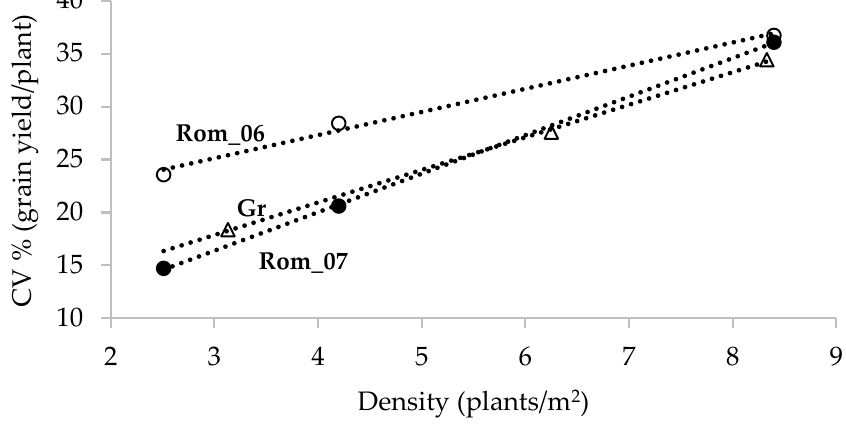
Figure 1. The positive association of CV for single-plant grain yield with density depicted in two groups of seven hybrids, the first across two seasons (Rom_06, and Rom_07) and the second for a single season (Gr). Data from Tokatlidis et al.